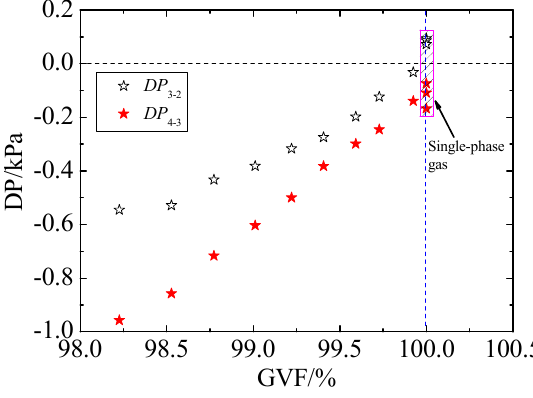
Figure 13. Pressure difference between pressure tapings downstream of cone.